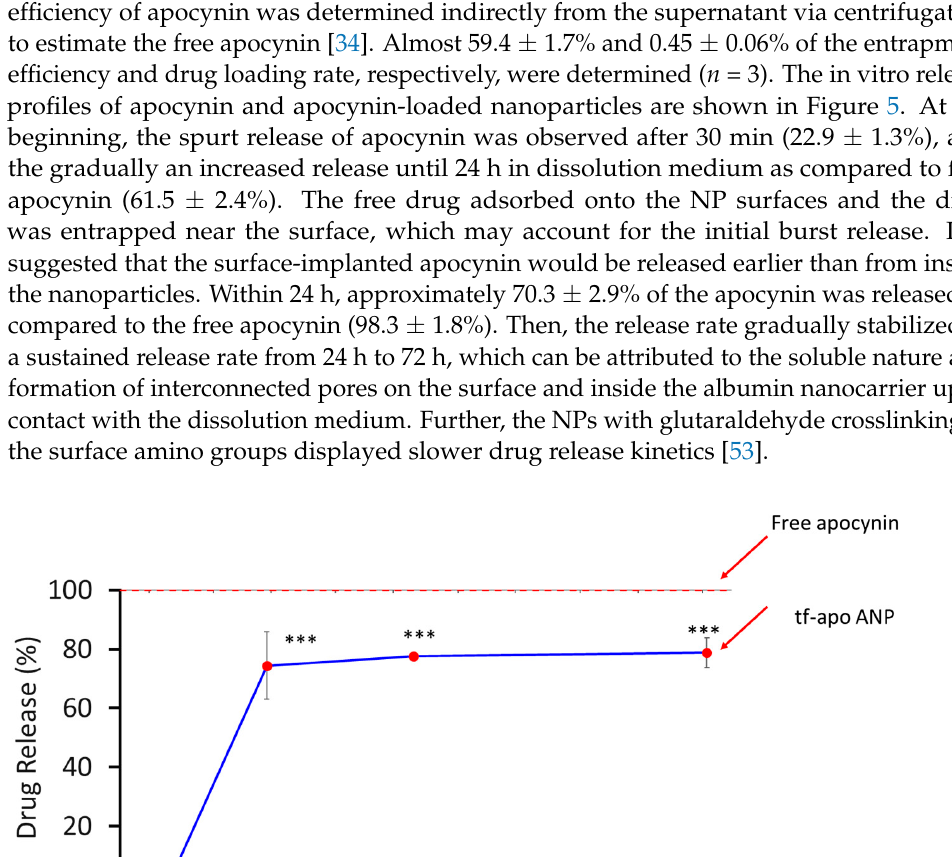
Figure 6. Cell viability assessment of apocynin and nanoparticle–apocynin conjugate treatments. Percentages of viable neuronal cells after treatment with increasing concentrations of apocynin alone (DRUG) or the nanoparticle–apocynin conjugate (NANO) for 48 h when combined with ( A ) 100 ng/mL lipopolysaccharide or ( B ) 100 μ M L-glutamic acid are shown. The data were analyzed